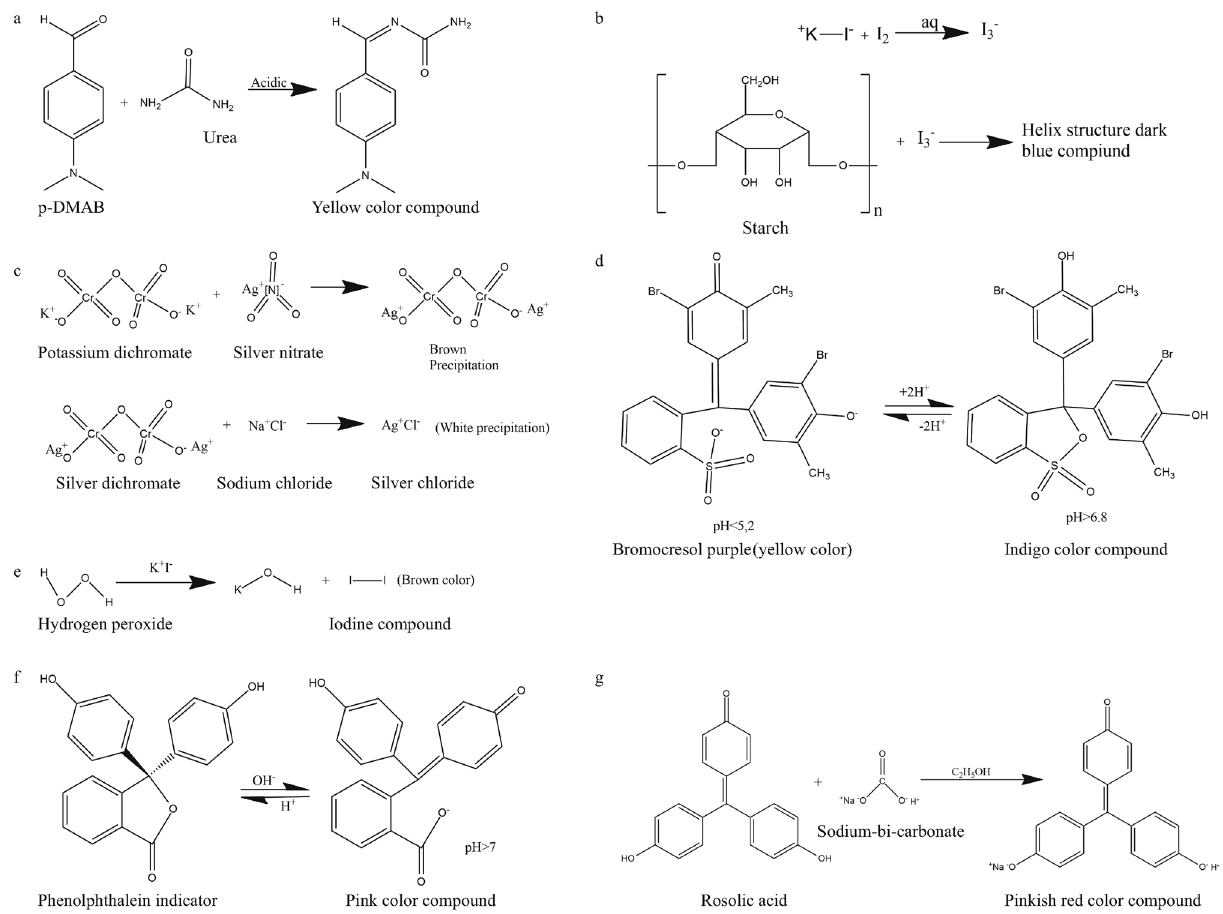
Figure 7. Schematic representation of the colorimetric reactions of ( a ) urea 73 , ( b ) Starch 74 , ( c ) salt 75 , ( d ) detergent 76 , ( e ) H 2 O 2 77 , ( f ) Soap 78 , and ( g ) NaHCO 3 79